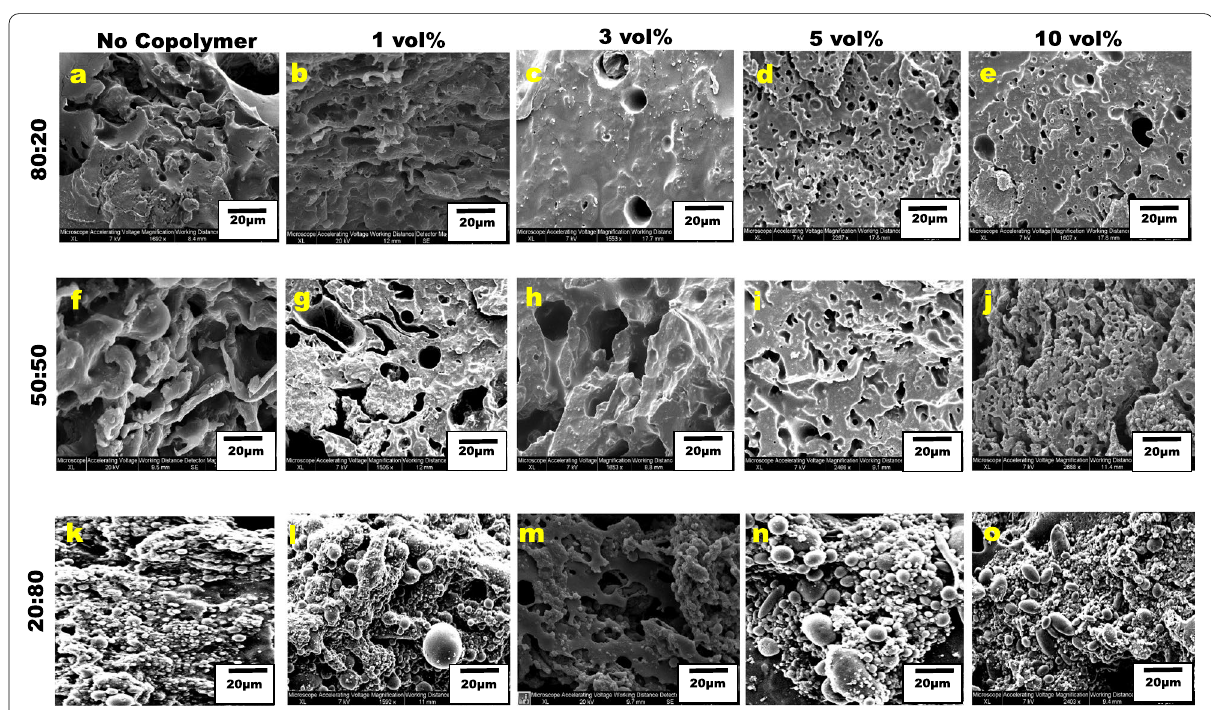
Fig. 4 SEM Micrograph of PP/PS/ 2 vol% MWCNT/ SEP diblock copolymer. Going from left to right, the diblock copolymer concentration increases and going from top to bottom PS amount increases in the blend composition PS phase was extracted in all the composites using